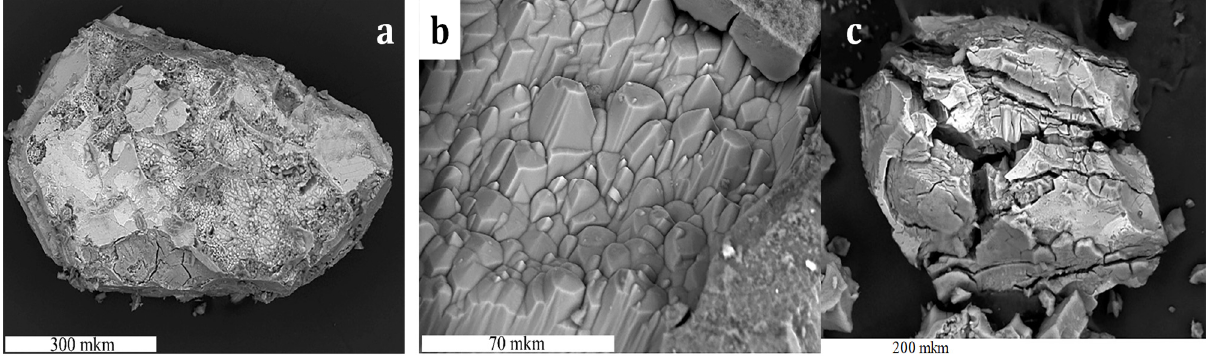
Figure 6. Surface of eudialyte grain ( a ) and area with serrate morphology ( b ) after leaching with EC treatment. Eudialyte grains after acid leaching with the application of US treatment ( c ).